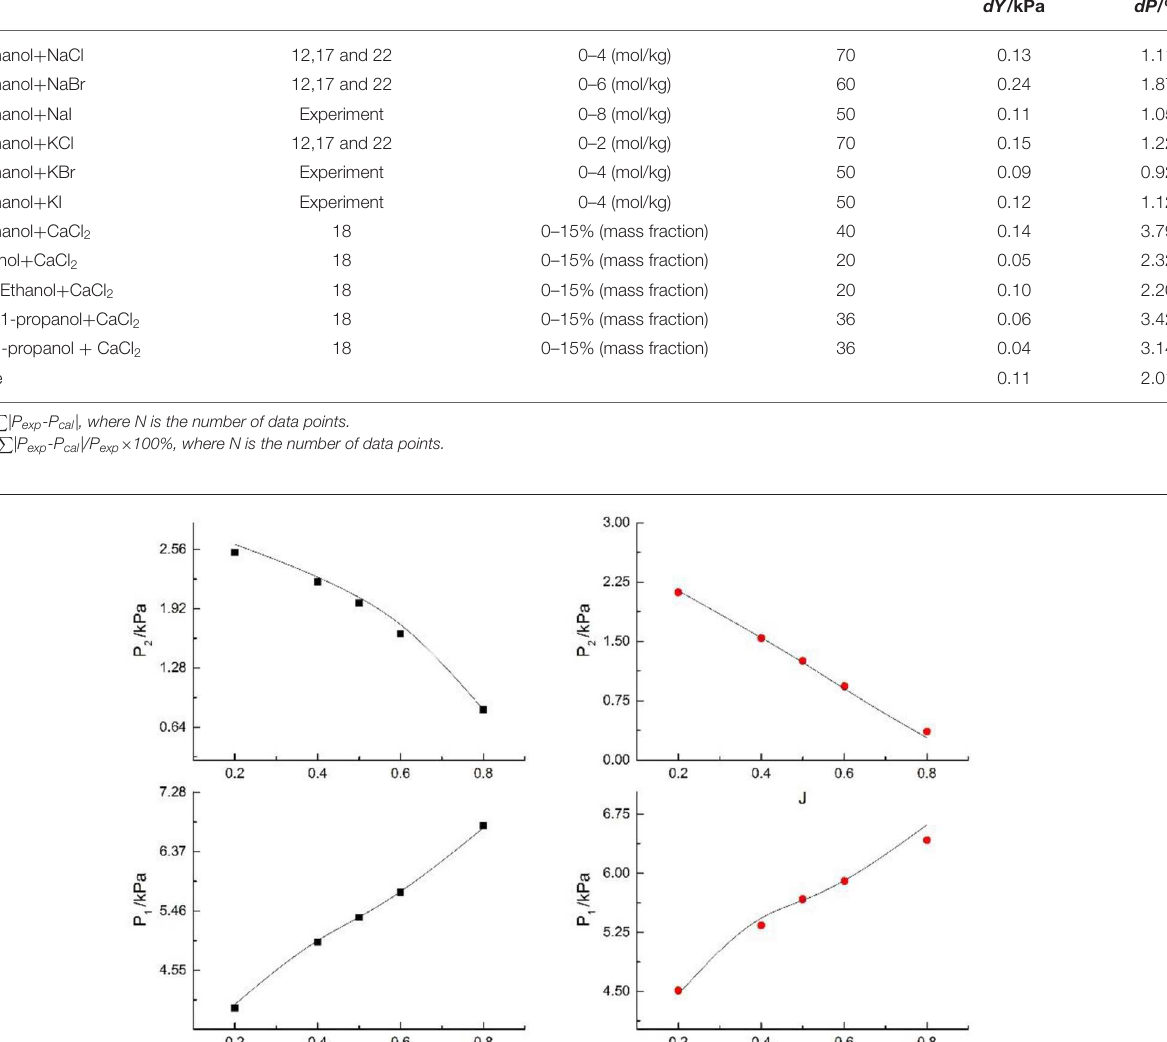
TABLE 5 | Correlation of VLE data for mixed-solvent systems at 298.15K. Systems